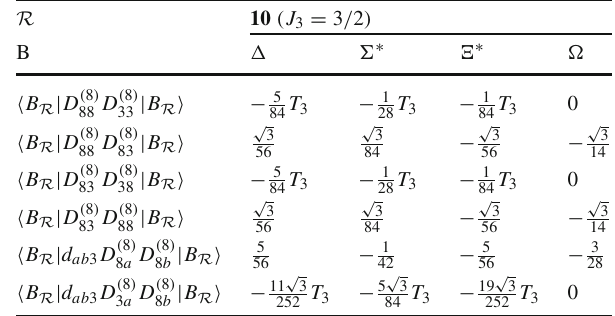
Table 10 The matrix elements of the collective operators of the m s corrections to the magnetic dipole form